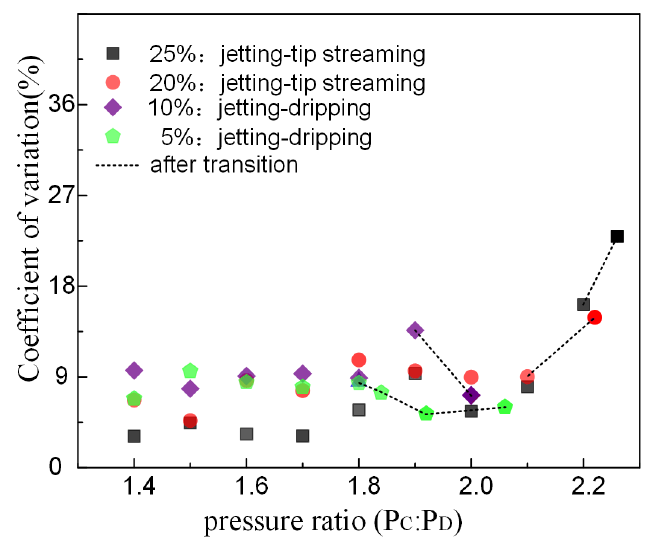
Figure 5. The coefficients of variation for poly (ethylene glycol) diacrylate (PEGDA) droplets on the basis of the pressure ratio and the bulk concentration of surfactant. CV = standard deviation/mean.